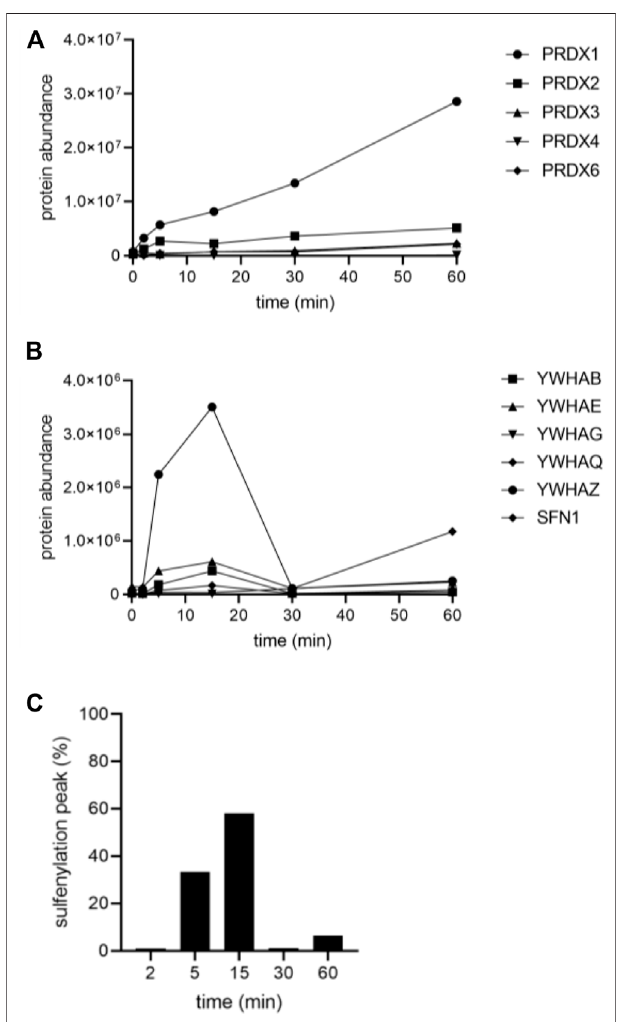
FIGURE 5 | Sulfenylation kinetics of various c-IBD-SBP-YAP1C interactors in response to peroxisomal H 2 O 2 production. Flp-In T-REx 293 cells expressing po-DD-DAO and c-IBD-SBP-YAP1C were incubated in DPBS containing 10 mM 3-AT and 10 mM D-Ala. At selected time points (0, 2, 5, 15, 30, and 60 min), free thiol groups were blocked with NEM. Next, the IBD-SBP-YAP1C-containing protein complexes were af fi nity puri fi ed, and the c-IBD-SBP-YAP1C interaction partners were eluted with reducing agent and processed for LC-MS/MS analysis (see Materials and Methods). (A) PRDX trapping by c-IBD-SBP-YAP1C (PRDX5 was not identi fi ed as hit). (B) 14-3-3 trapping by c-IBD-SBP-YAP1C (YWHAH was not identi fi edashit). (C) Percentagedistributionofthesulfenylationpeaktimeofall c-IBD-SBP-YAP1C interactors (n, 429).